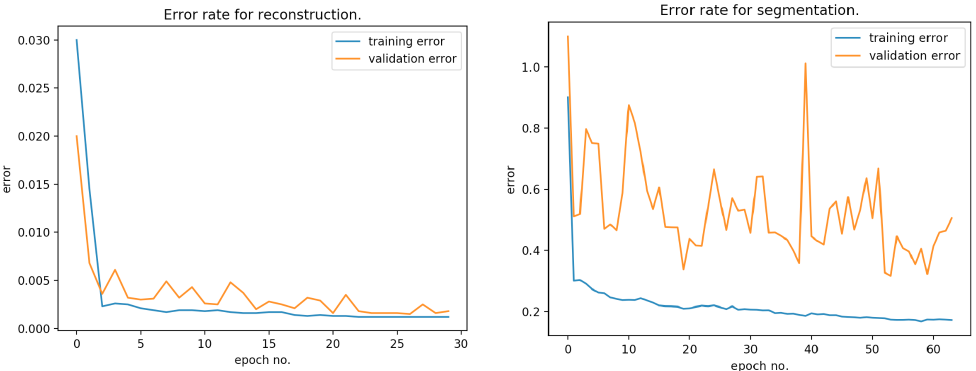
Figure 10. Error rate for reconstruction and segmentation over the training and validation data.